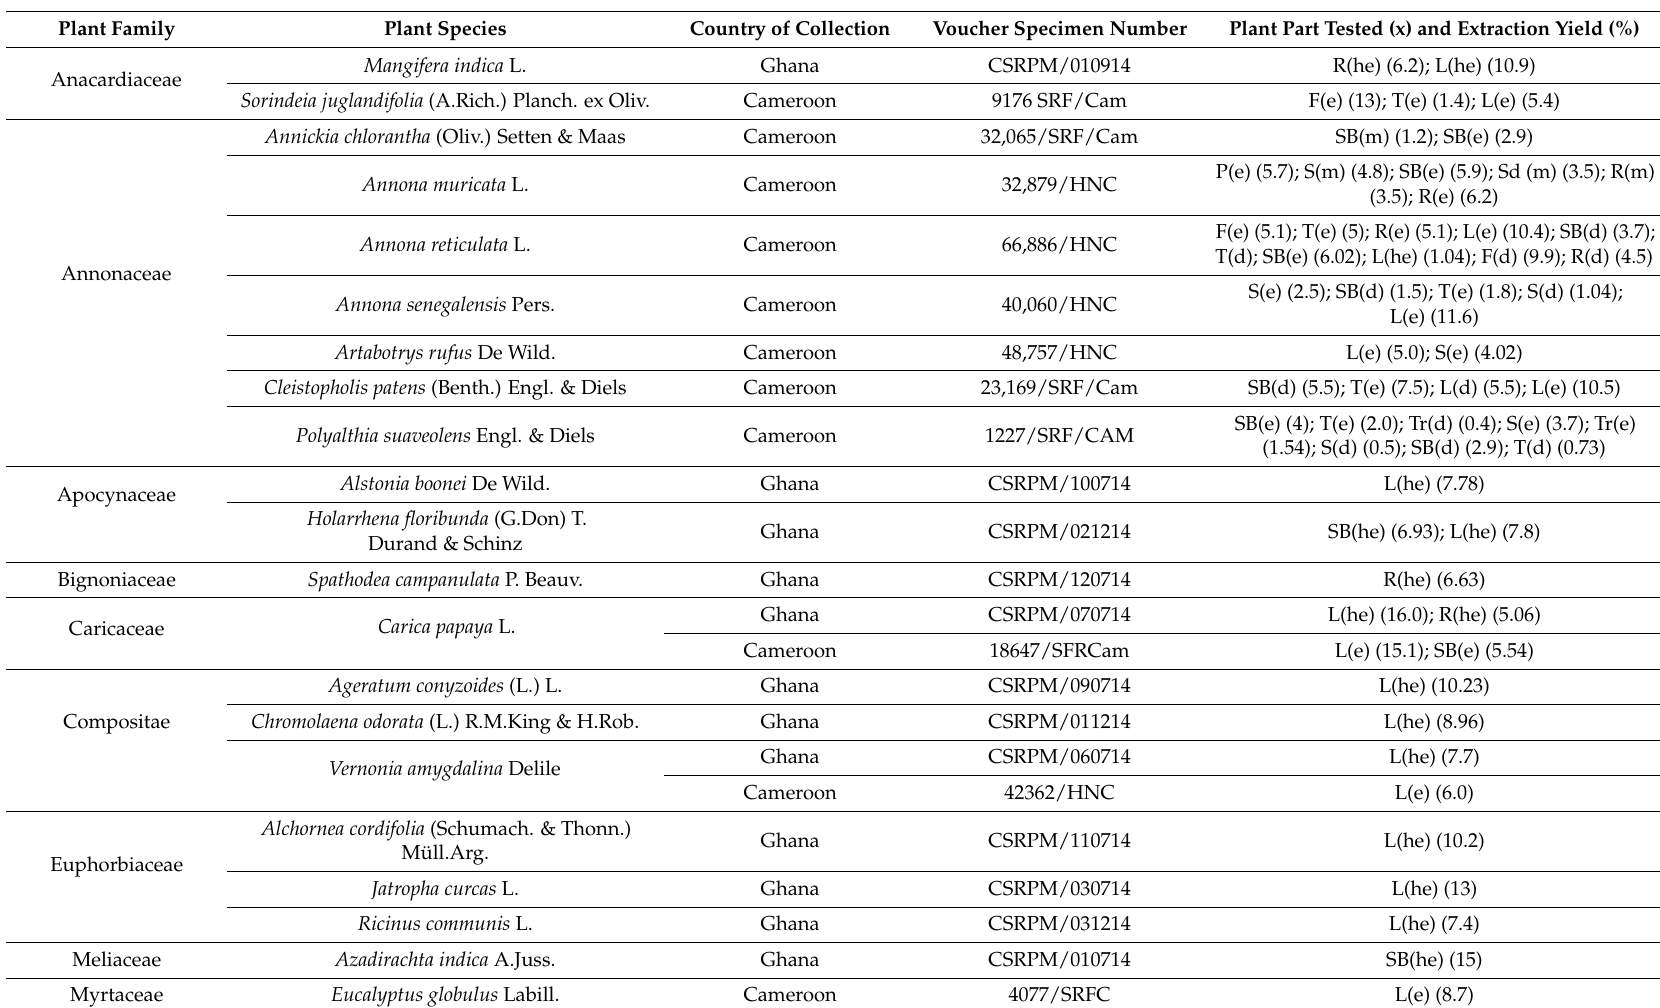
Table 1. Brief overview of plants used for the in vitro anti-mycobacterial